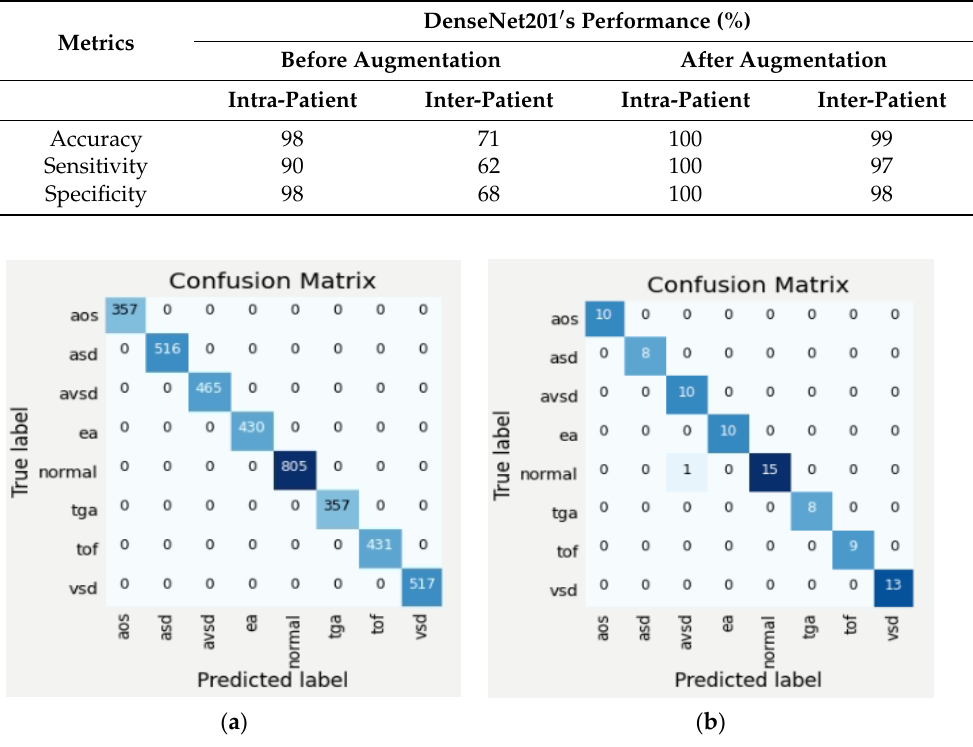
Figure 6. Confusion matrices of eight-class by DenseNet201 model with intra- and inter-patient scenarios after data augmentation ( a ) intra-patient; ( b ) inter-patient. Table 6. Eight-class classification average performance after data augmentation.